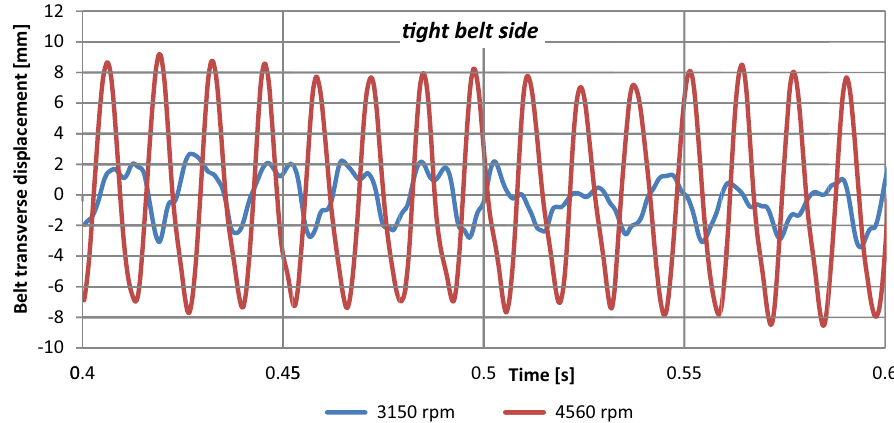
Figure 5: Transverse displacement measured 70 mm from left belt - pulley contact point at tight part of belt, for selected engine rotational speeds ( 3,150 and 4,560 rpm ) , constant transmission ratio ( 0.9 ) , and full throttle opening.